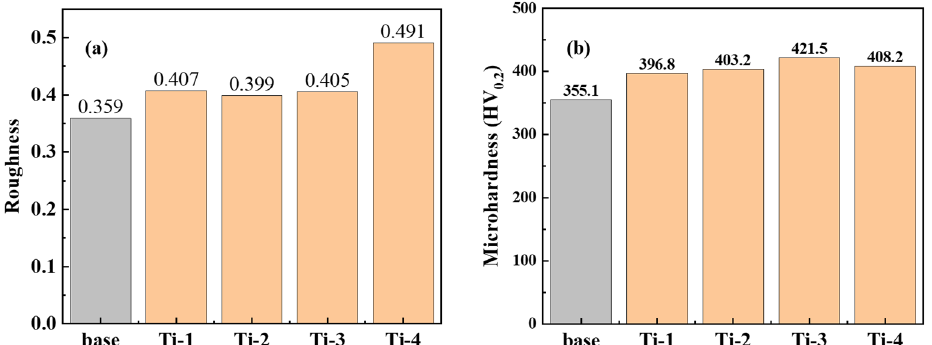
Figure 5. ( a ) Surface roughness, ( b ) surface